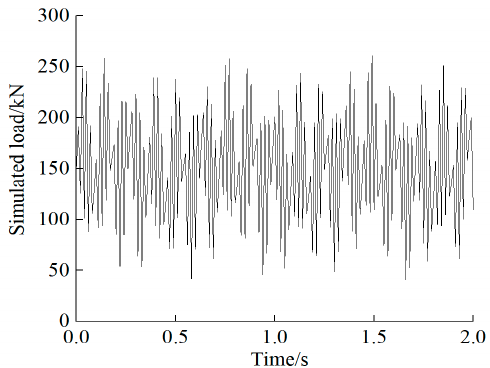
Figure 12. Time history curve of simulated train load.